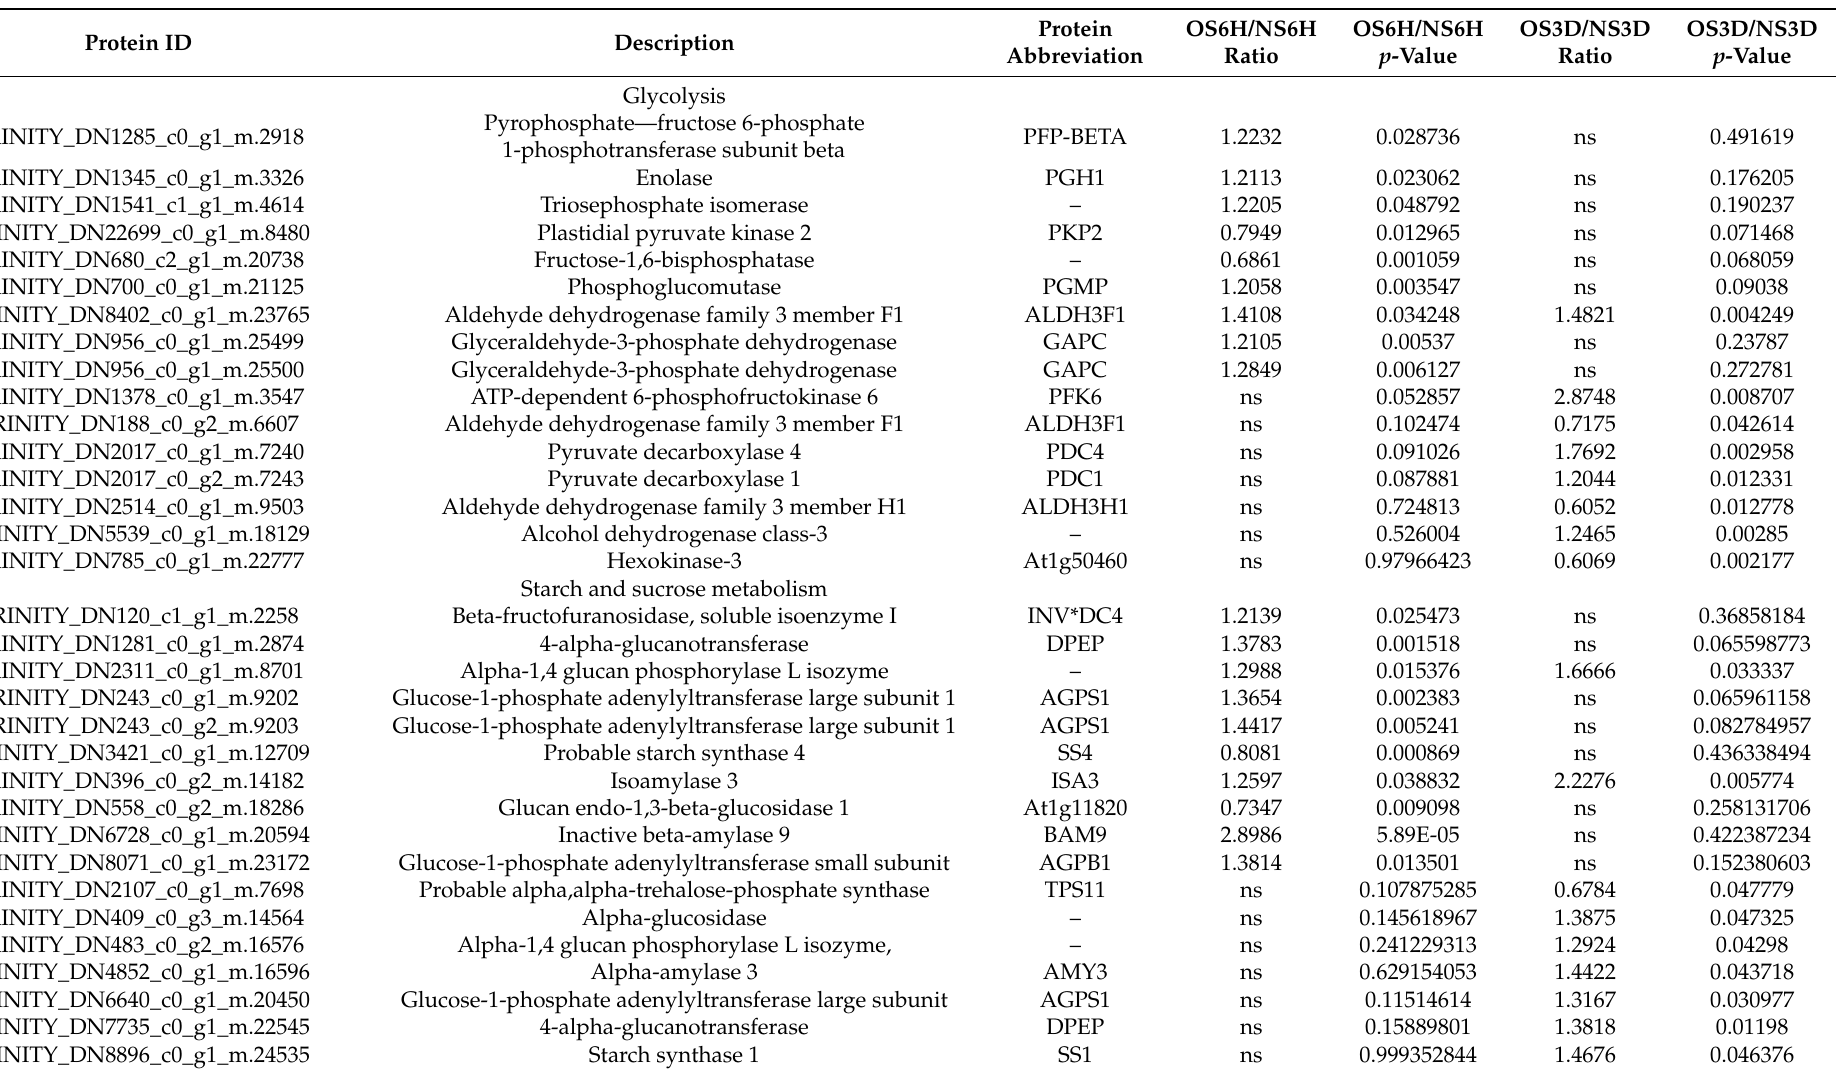
Table 1. DAPs are involved in carbohydrate